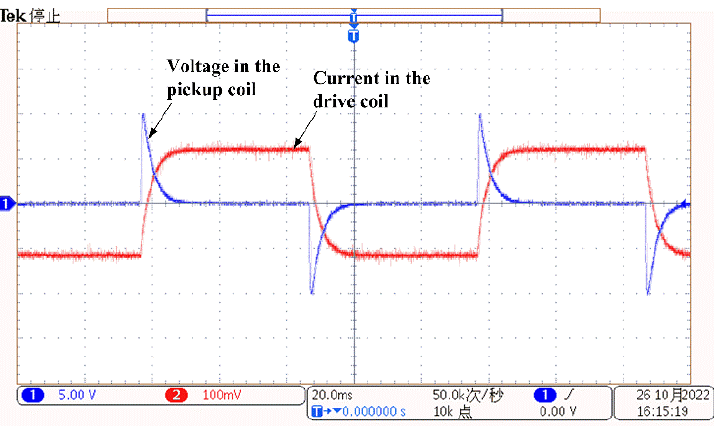
Figure 11. PECT probe’s driving and pickup signals, monitored using an oscilloscope.